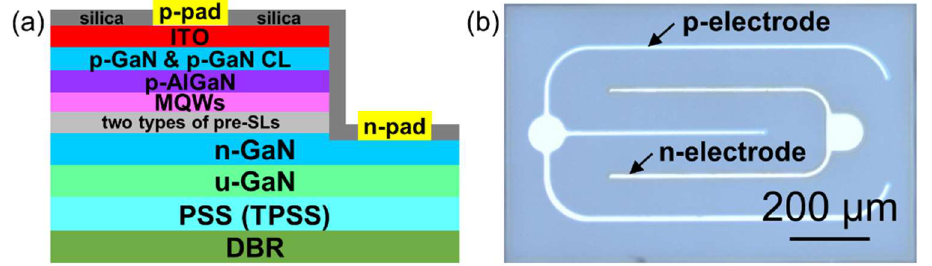
Figure 1. ( a ) Schematic diagram of the LED structure from a cross-sectional view including epilayers and technical processes; ( b ) Optical photo of the as-fabricated lateral LED chip.